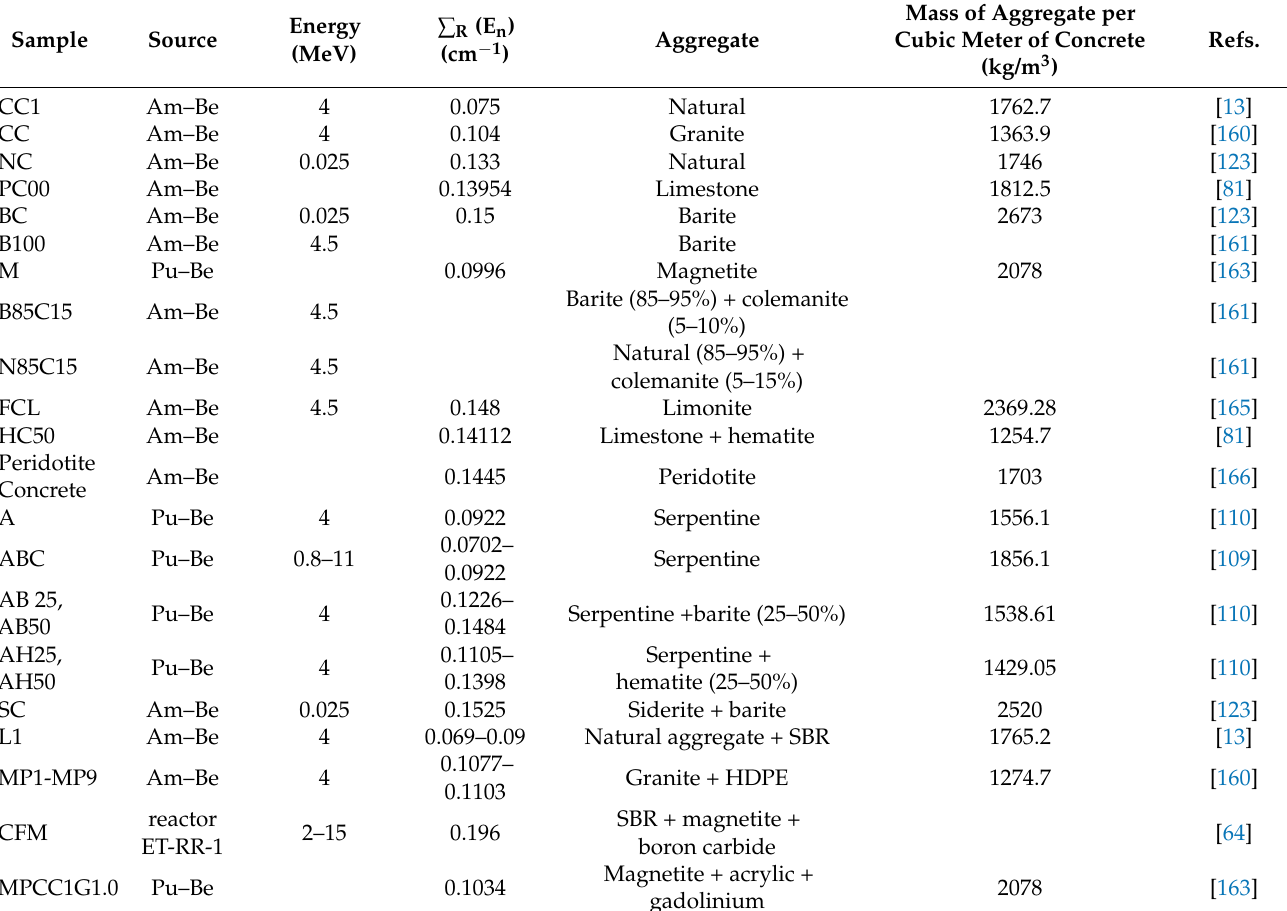
Table 4. Macroscopic removal cross section value concrete sample with different types of